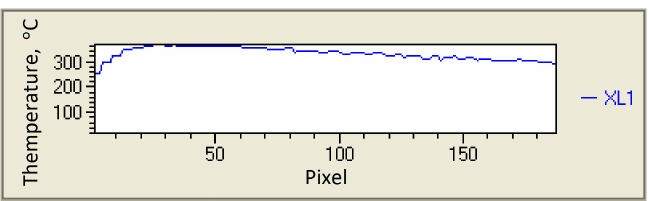
Figure 6. The heat distribution along the centre line of the chip obtained for the insert coated with AlTiN, with cutting parameters of v c = 100 m/min., f = 0.20 mm/rev.